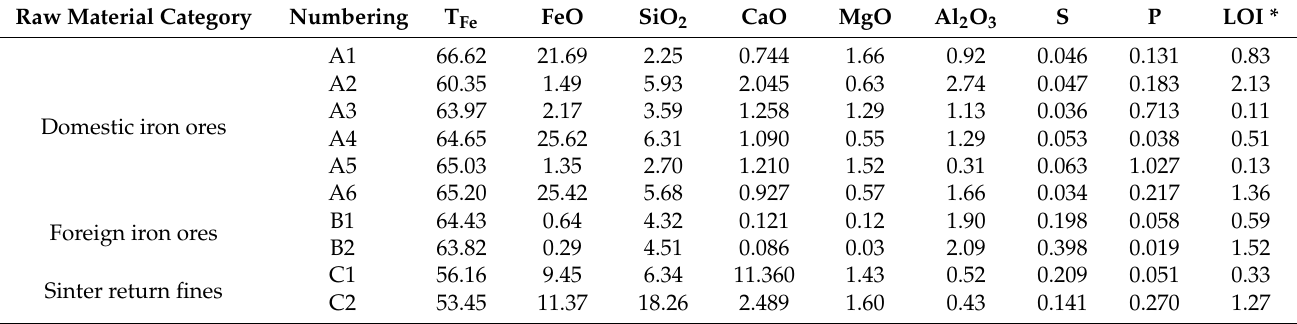
Table 1. Main chemical composition of iron ore powder samples (%).